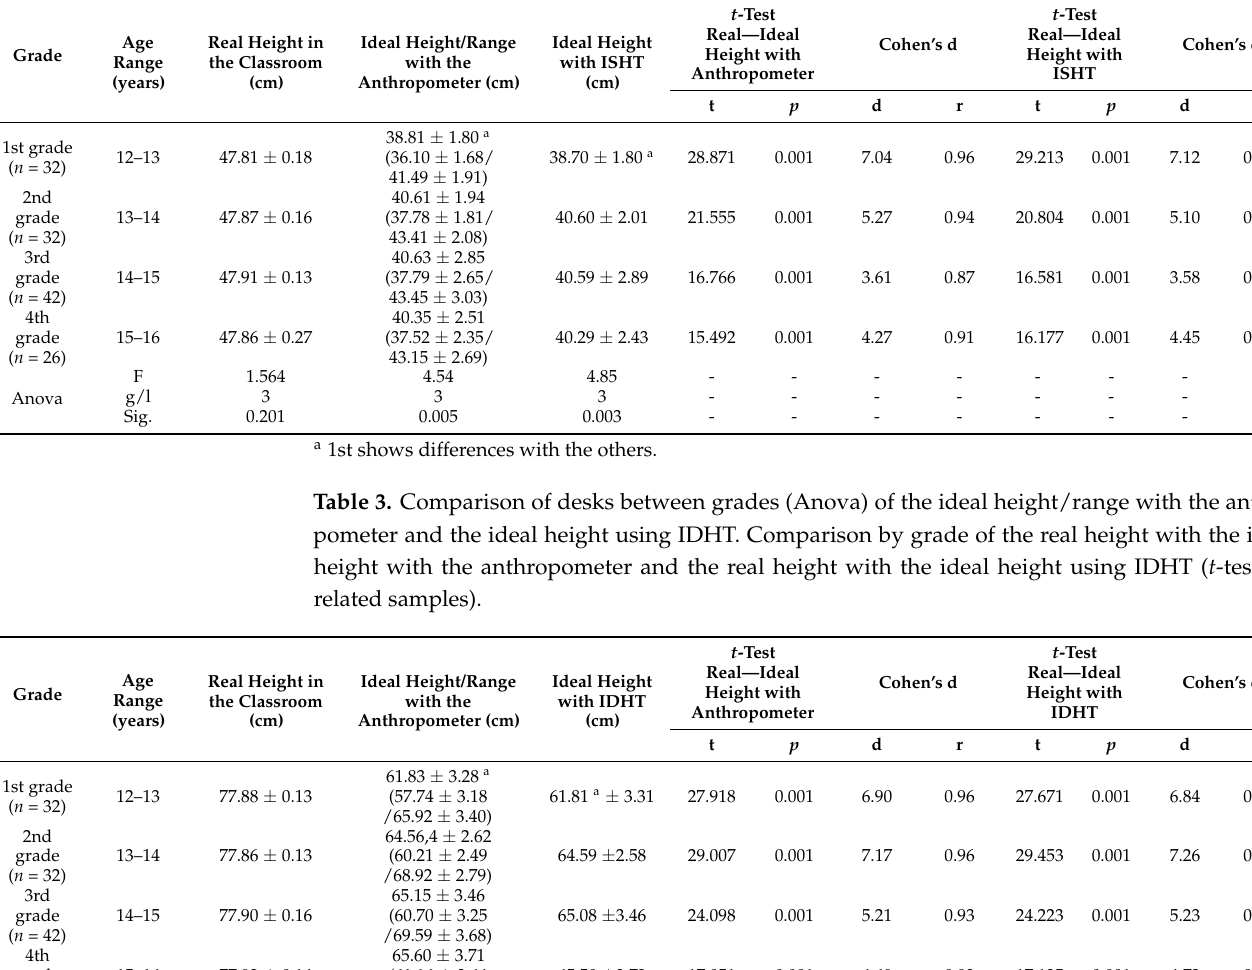
Table 2. Comparison of chairs between grades (Anova) of the ideal height/range with the anthro- pometer and the ideal height using ISHT. Comparison by grade of the real height with the ideal height with the anthropometer and the real height with the ideal height using ISHT ( t -test for related samples).